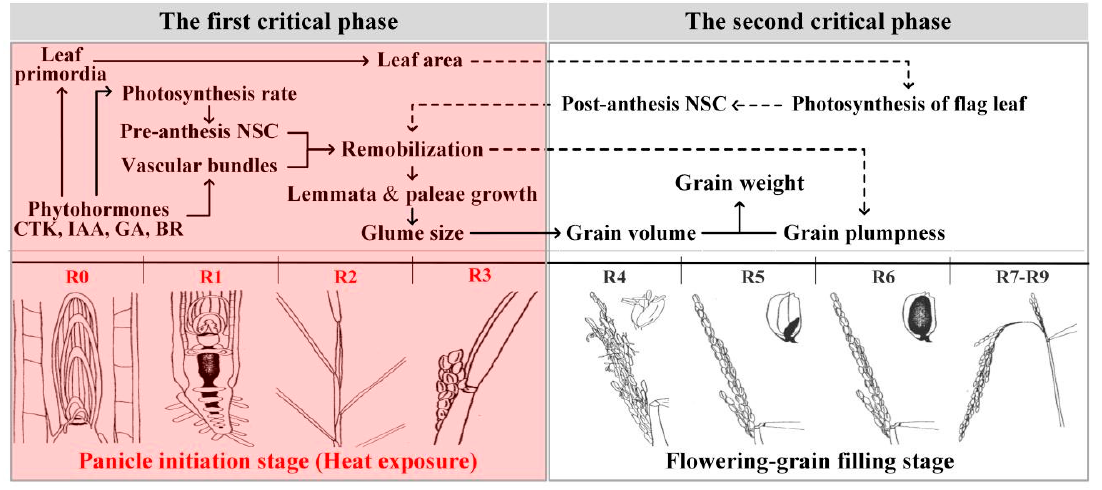
Figure 2. Proposed mechanisms of reduced rice grain weight in terms of phytohormonal regulation and assimilate supply under heat during the panicle initiation stage. R0: initiation of panicle development; R1: formation of panicle branches; R2: formation of the flag leaf collar; R3: panicle emergence from the boot; R4: at least one floret on the main panicle reach anthesis; R5–R6: one or more caryopsis on the main panicle elongate to the end of the hull; R7–R9: grains on the main stem panicle show yellow or brown hulls. (the illustrations of the reproductive stages with morphological markers are adapted from those by Wu et al.